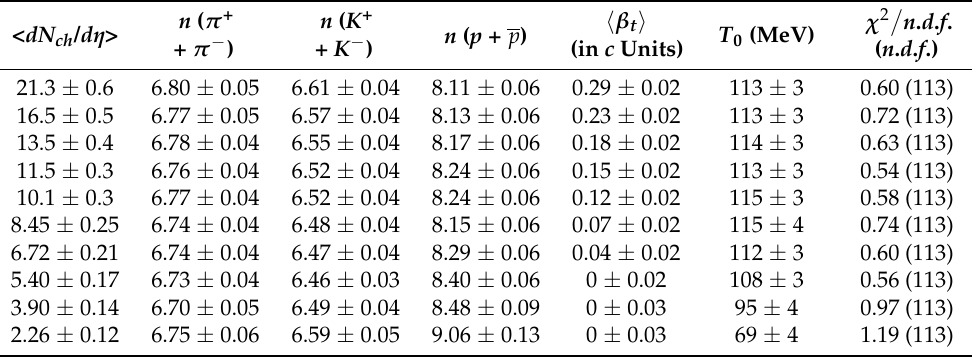
Table 3. Parameters extracted using combined minimum χ 2 fits with the Hagedorn function with included transverse flow (Equation (7)) of p t distributions of particles in various groups of < dN ch / d η > in proton-proton collisions at ( s ) 1/2 = 7 TeV. The fitted p t ranges are [0.5–20.0] GeV/ c for π + + π − , [0.2–20.0] GeV/ c for K + + K − , and [0.3–20.0] GeV/ c for p + p . < dN ch / d η